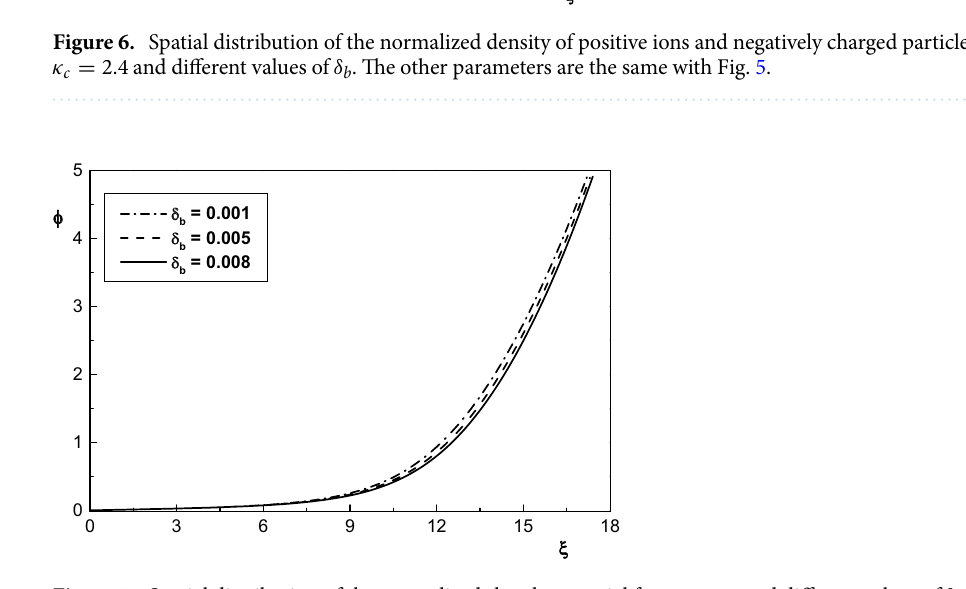
Figure 7. Spatial distribution of the normalized sheath potential for κ c = 2.4 and different values of δ b . The other parameters are the same with Fig.